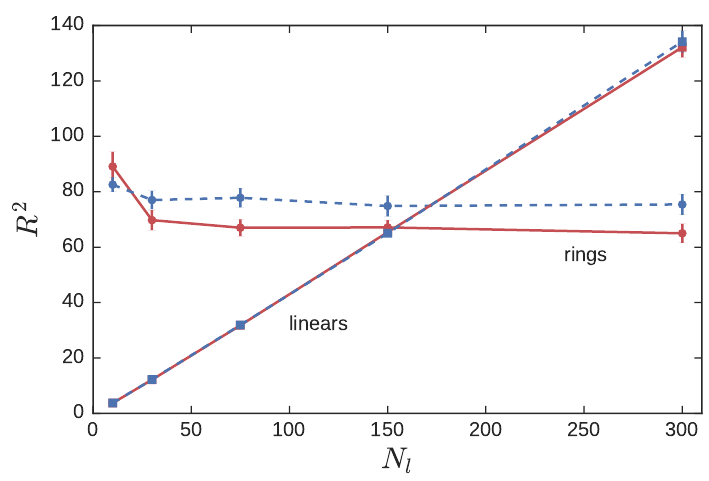
Figure 4. The squared radius of gyration of RPs (circles) and LPs (squares) in asymmetric blends with N r = 300, and N l varied between 10 and 300. The linear fraction φ l is held fixed at 0.9. Red symbols connected with solid lines represent non-crossing simulations, while blue symbols and dashed lines represent crossing